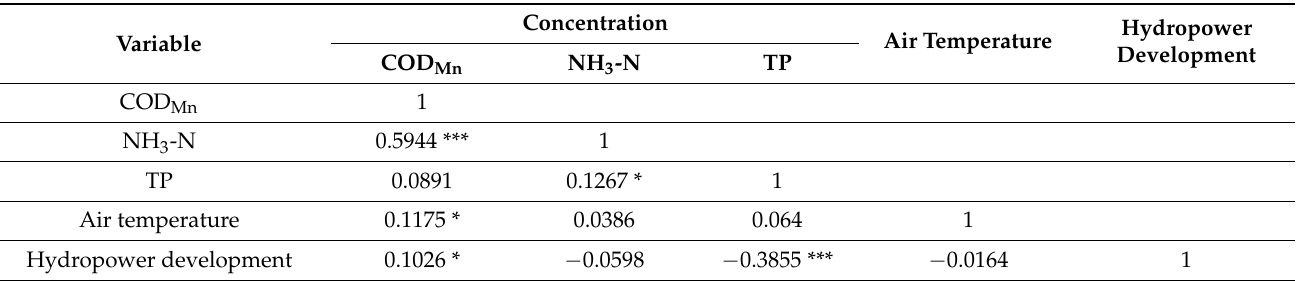
Table 5. Analysis of the correlation coefficient between treatment variables of hydropower develop- ment and water quality